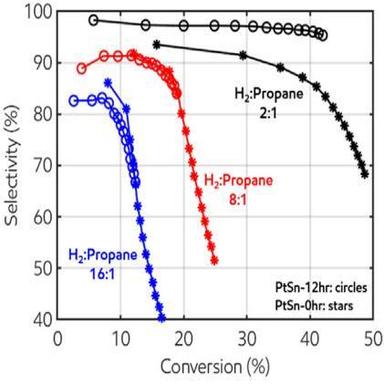
Selectivity towards PDH of PtSn-12hr (circles) and PtSn-0hr (stars) at varying H2:propane ratios (black: 2:1, red: 8:1, blue: 16:1). (For interpretation of the references to colour in this figure legend, the reader is referred to the web version of this article.)